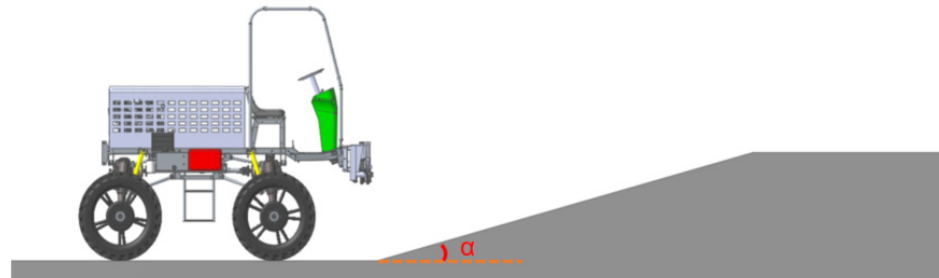
Figure 4. Climbing model of HGPM.